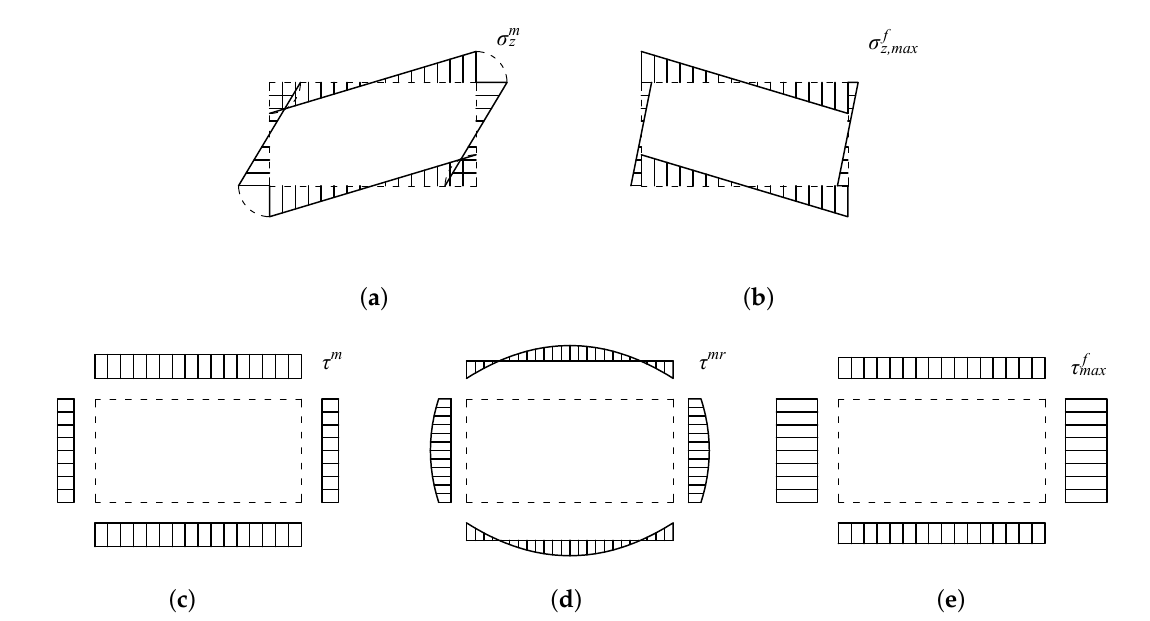
Figure 7. Stresses in the torsional mode: ( a ) membrane longitudinal normal stress, ( b ) flexural longitudinal normal stress, ( c ) active membrane tangential stress, ( d ) reactive membrane tangential stress, and ( e ) flexural tangential stress. ( b , e ) the index max denotes evaluation at the top/bottom face of the plates (i.e., at y i = ± t i